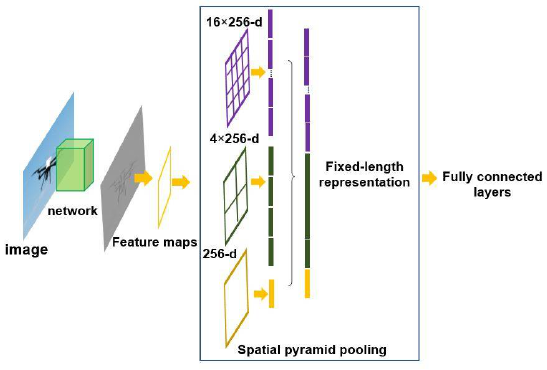
Figure 9. Spatial pyramid pooling (SPP) block.